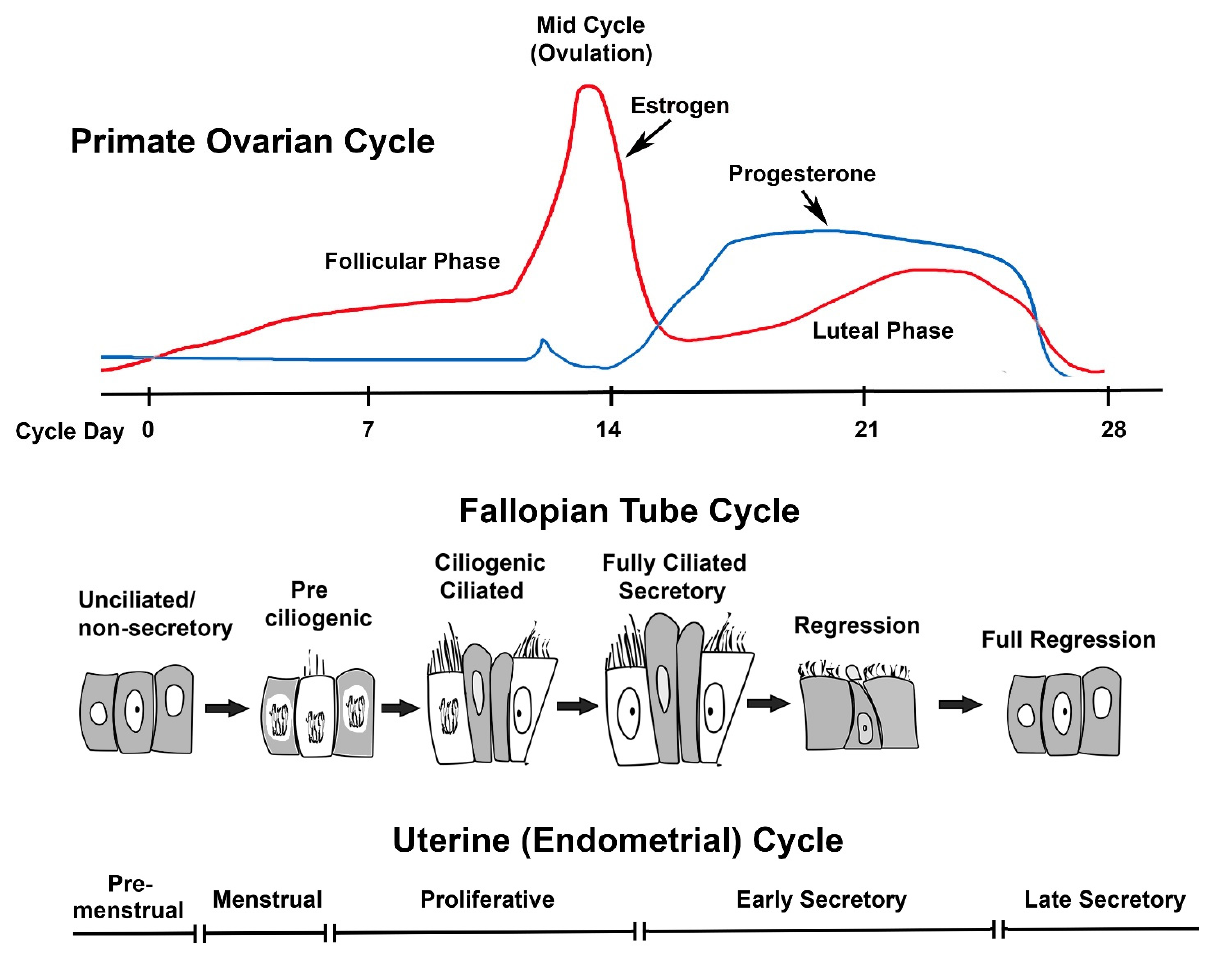
Figure 1. The fallopian tube cycle. Changes in the level of P 4 in the presence of E 2 drive cytologic changes in the fallopian tube epithelium. The upper panel shows an idealized primate ovarian cycle. In macaques, estrogen levels usually are 30–50 pg/mL at menstruation, rise during the follicular phase, and surge before ovulation. Post-ovulation, E 2 declines but remains >50 pg/mL during the luteal phase. Progesterone (P 4 ) levels are minimal in the follicular phase and rise significantly in the luteal phase. Estrogen levels ≥ 50 pg/mL drive cell proliferation in the pre-ciliogenic and ciliogenic/ciliated phases of the fallopian tube cycle and are necessary for maintaining differentiated ciliated secretory phenotype. The increase in P 4 triggers regression of the epithelium despite continued E 2 in the luteal phase. The lower panel depicts the phases of the uterine menstrual cycle, where the follicular and luteal phases are referred to as proliferative and secretory phases, respectively.